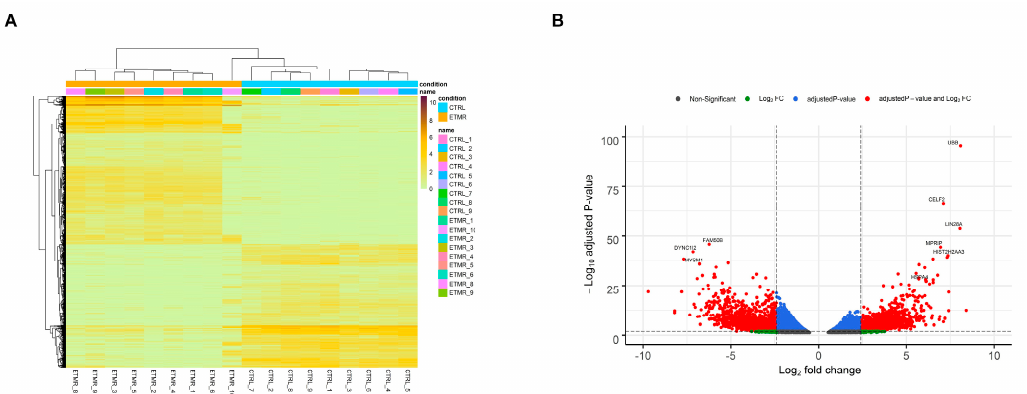
Figure 1. Overview of the differentially expressed genes (DEGs). ( A ) Heatmap of the differentially expressed transcripts. Each row read represents a single transcript, and each column represents a sample in each condition. ( B ) Volcano plot overviews the DEGs and highlighting the top up-regulated and down-regulated genes. The log2 (FC—fold change) is plotted on the x -axis, and the negative log10 adjusted p -value is plotted on the y -axis. The horizontal line represents the cutoff of the adjusted p -value (0.001) and the vertical lines represent the cutoff of the log2 FC (2.4 and − 2.4).